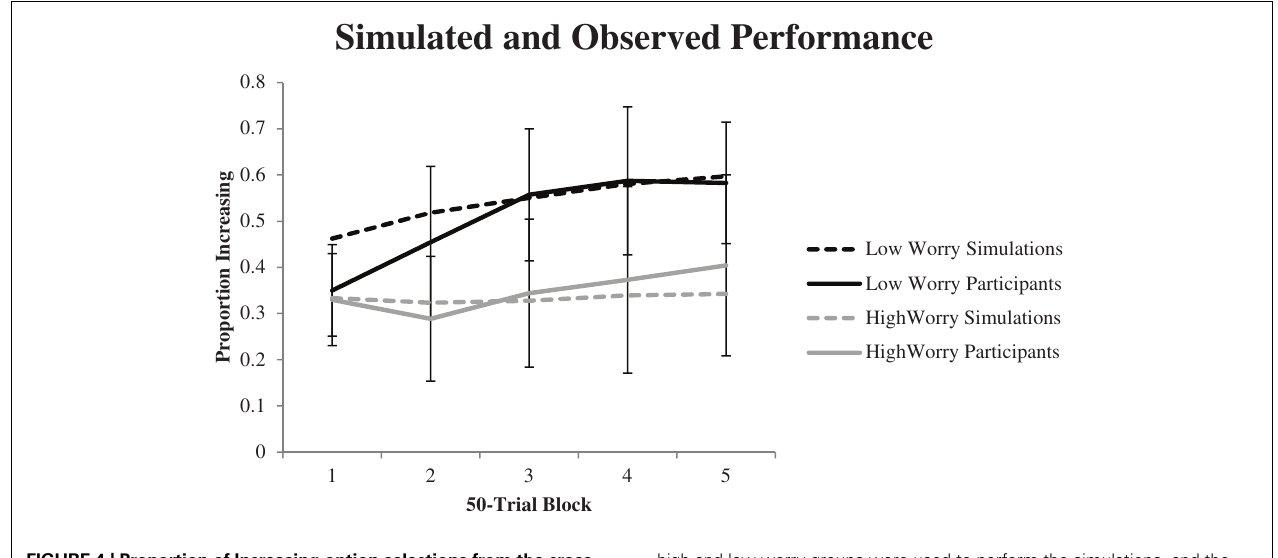
FIGURE 4 | Proportion of Increasing option selections from the cross validation analysis. Error bars represent 95% confidence intervals. Best-fitting parameter values from fourteen participants within each of the